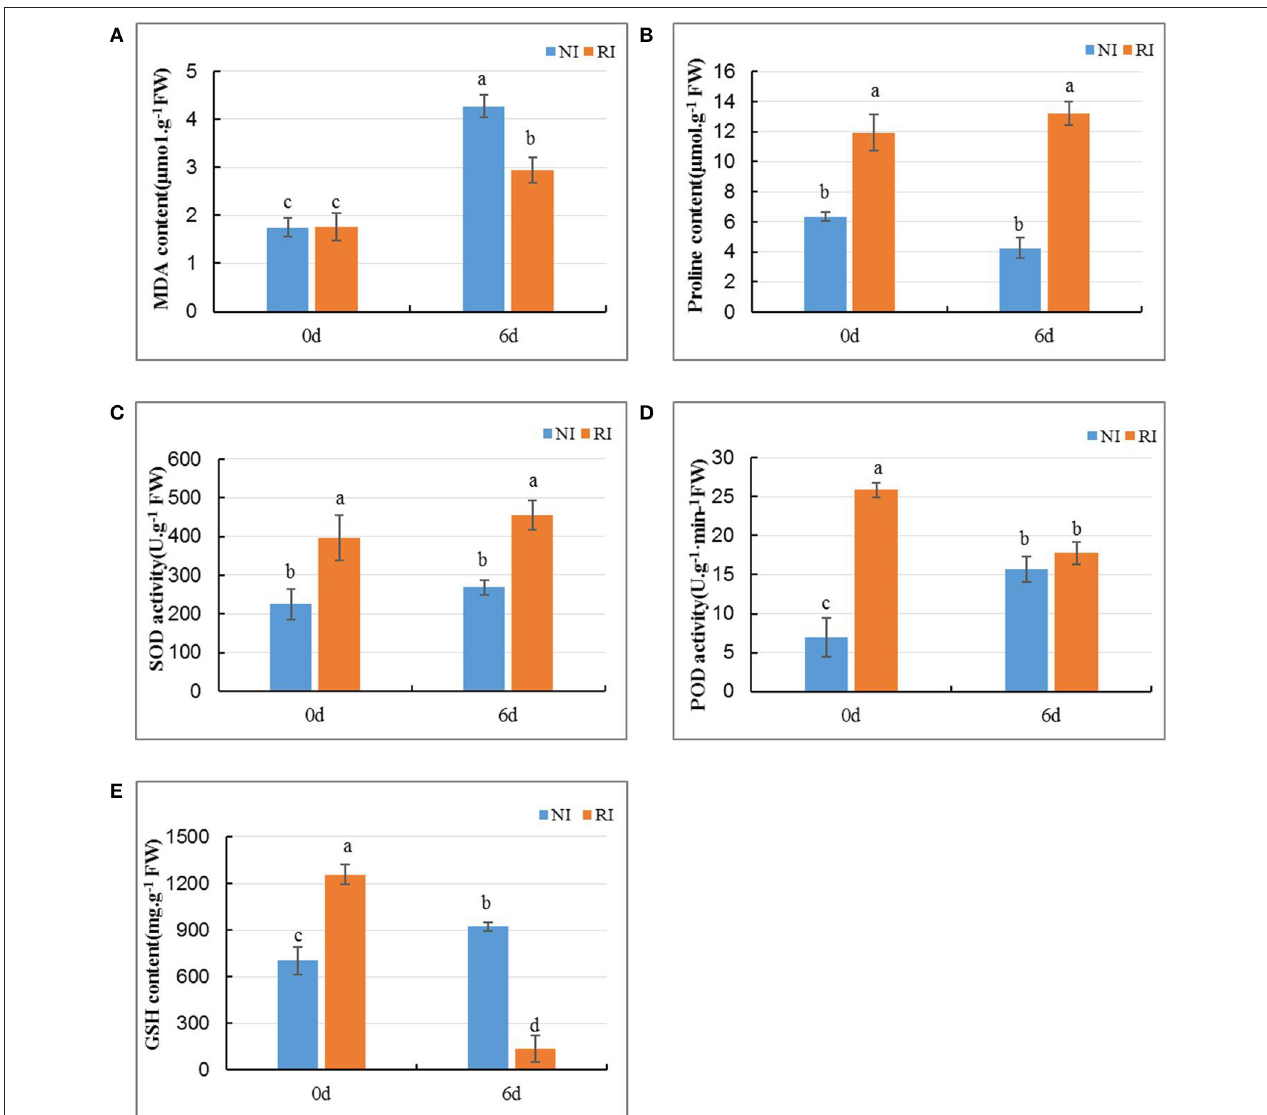
FIGURE 2 | Changes in MDA (A) and proline (B) and GSH (E) content and in the activities of SOD (C) , and POD (D) in the roots of alfalfa plants with (RI group) and without (NI group) rhizobium inoculation under alkali stress. Values are means of six replicates. Standard error bars annotated by different lower-case letters in the same stress type indicate significant differences at p < 0.05 according to Duncan’s